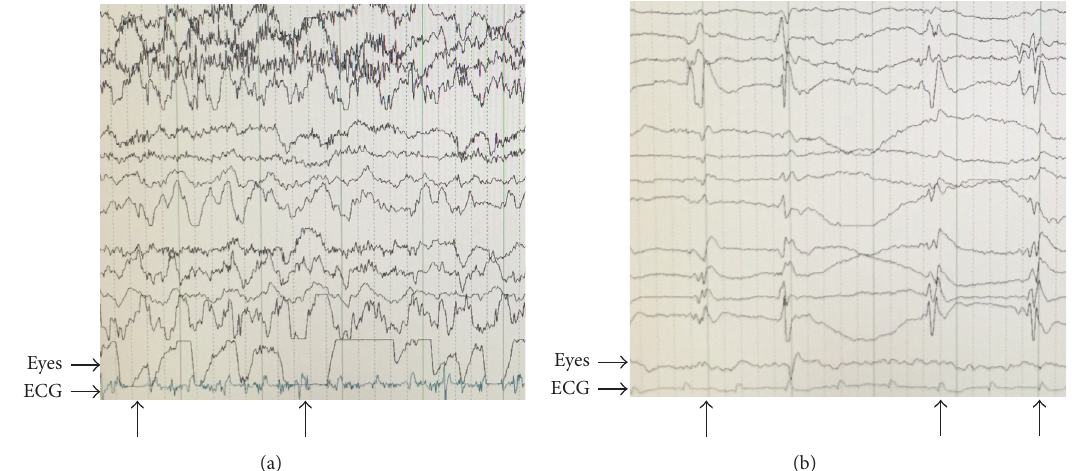
Figure 1: Electroencephalogram (EEG) displaying seizure-like activity at initial presentation (a) and at 10 days after admission (b). Arrows denote paroxysmal